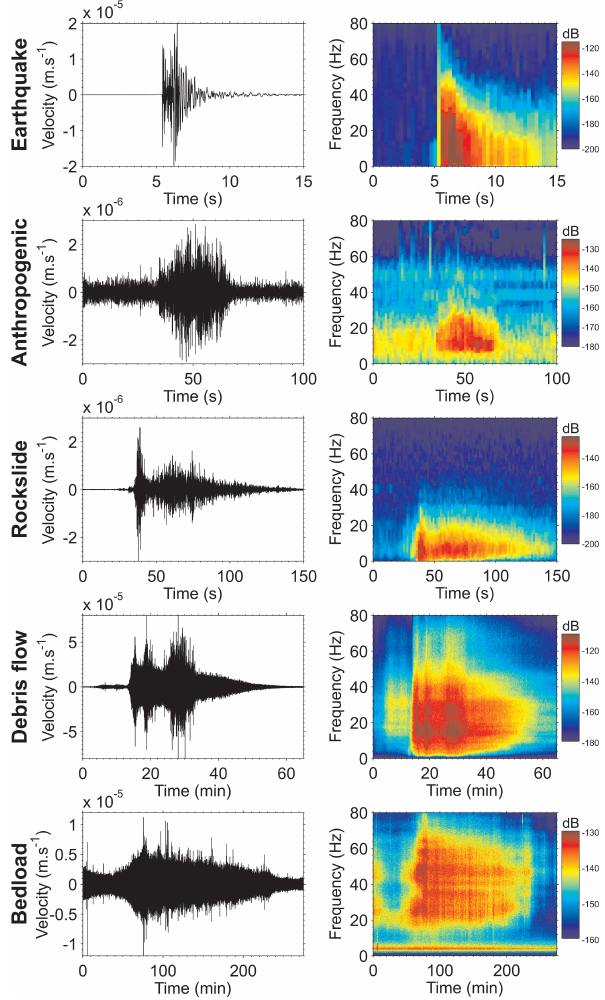
Figure 8. Characterization of seismic signals (left) with a time– frequency analysis (right). Each vertical seismogram is high-pass- filtered at 1Hz and the seismic energy from spectrograms is in deci- bels. We performed the analysis for a local earthquake (Switzerland, day 144/2013 20:57:25UTC), a public transport vehicle (GFZ Pots- dam), a rockslide (Illgraben, day 1/2013), a debris flow (Illgraben, day 203/2013) and bedload transport (Écrins, summer 2010), from top to